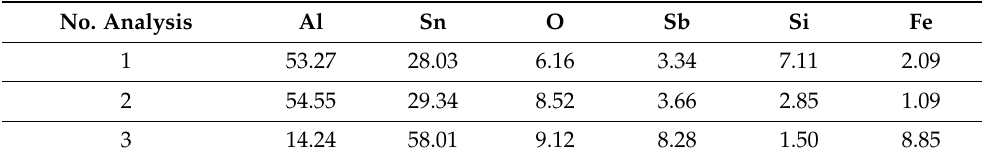
Table 6. EDX analysis of selected zones from Figure 4b on wear surface of hybrid material at a load of 40 N, mass norm., %.